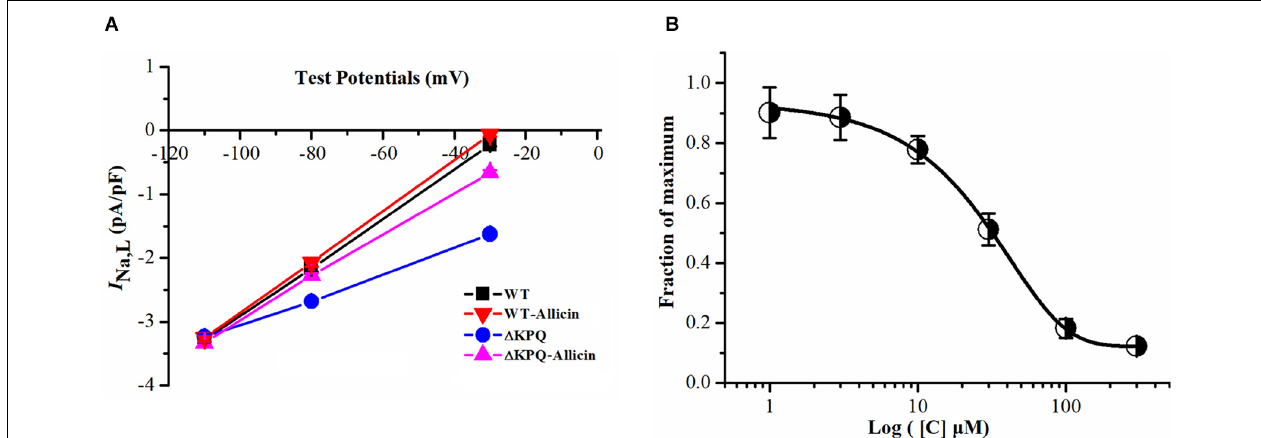
FIGURE 2 | Effect of Allicin on current–voltage and concentration dependence on the I Na , L of the (cid:49) KPQ-SCN5A mutation. (A) Representative current–voltage relationship (voltage dependence) of the I Na , L for the (cid:49) KPQ-SCN5A mutation. (B) The effect of Allicin on concentration–response relationship on the I Na , L of the